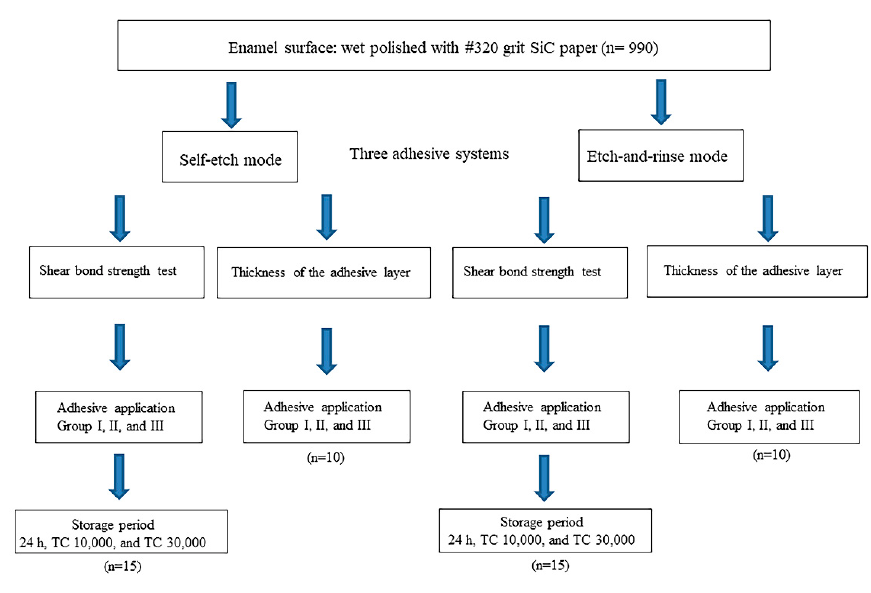
Figure 1. Flow diagram of this study.